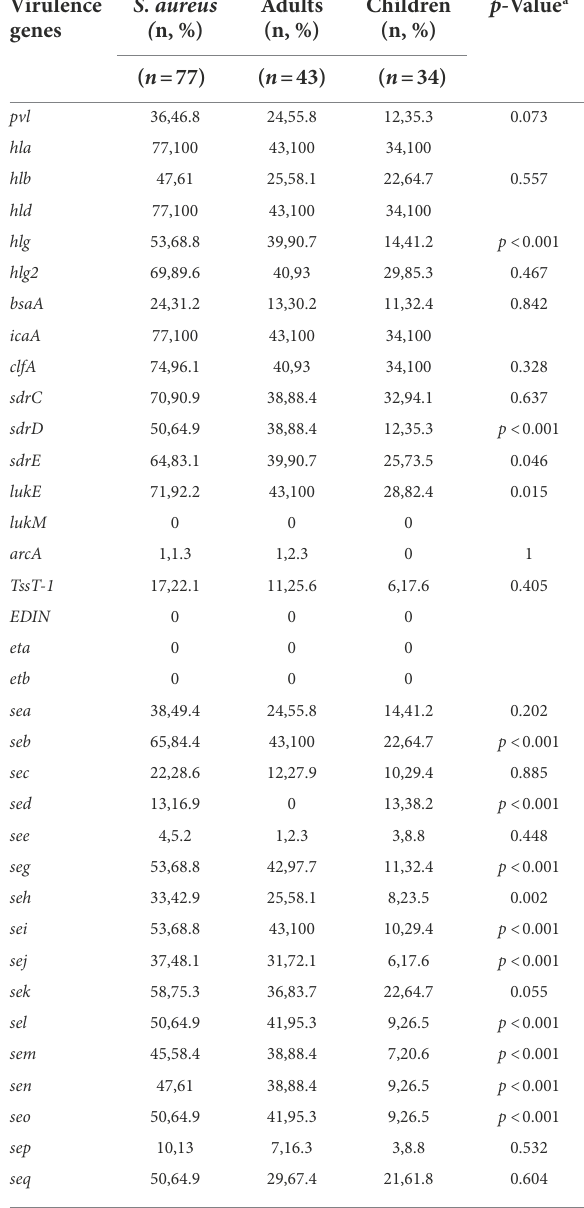
TABLE 3 Frequencies of virulence genes among methicillin-resistant S. aureus (MRSA) isolates obtained from adults and children. Virulence